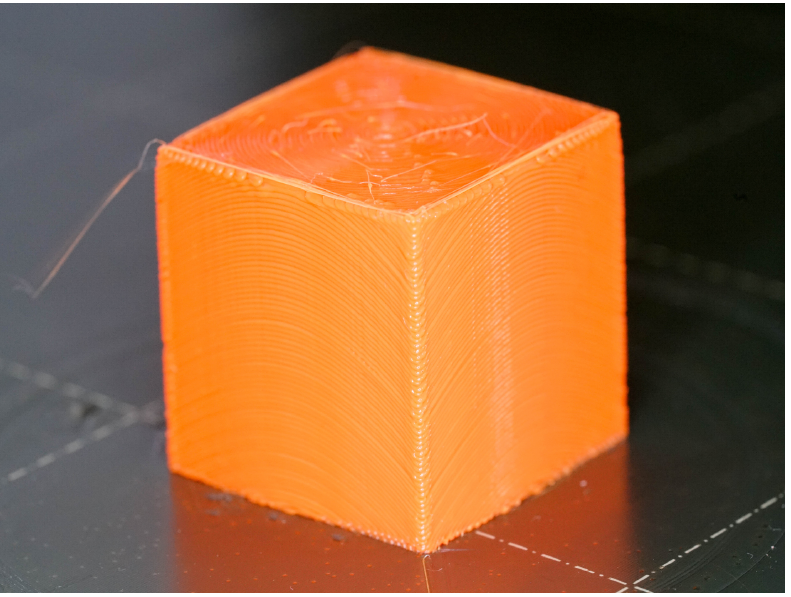
Figure 12. Finished cube, with a radial oriented